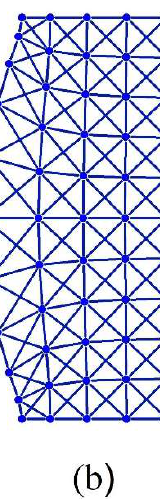
Figure 5. Deformation configuration (scaled) of the 2DoF x-braced lattice ( k = 0.93, q = 4, m = 0 → 10, n = 0 → 4) given by the analytical Equations (30) and (31) in ( a , b ), respectively.